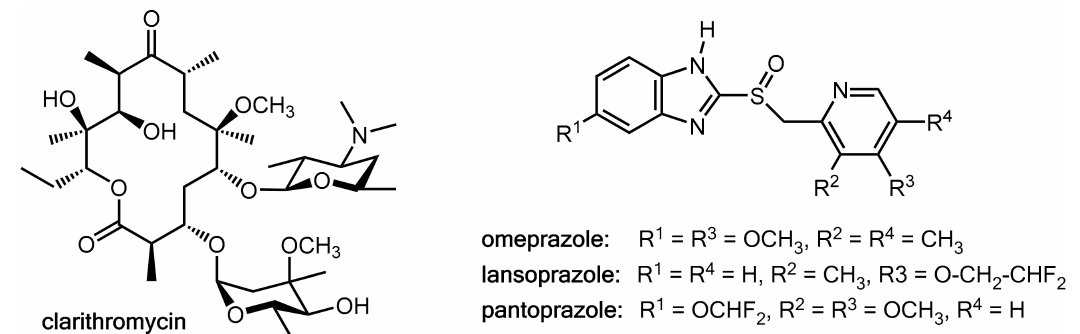
Figure 8. Structures of the macrolide antibiotic clarithromycin and the proton pump inhibitors omeprazole, lansoprazole, and pantoprazole.